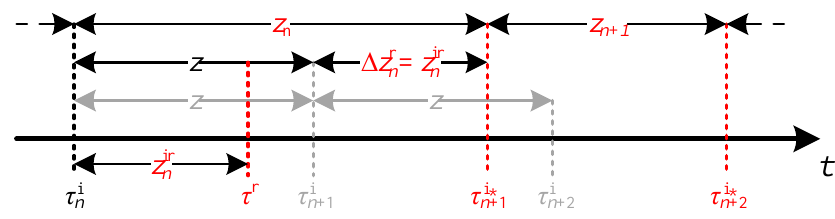
Figure 3. Dynamic inspection intervals considering